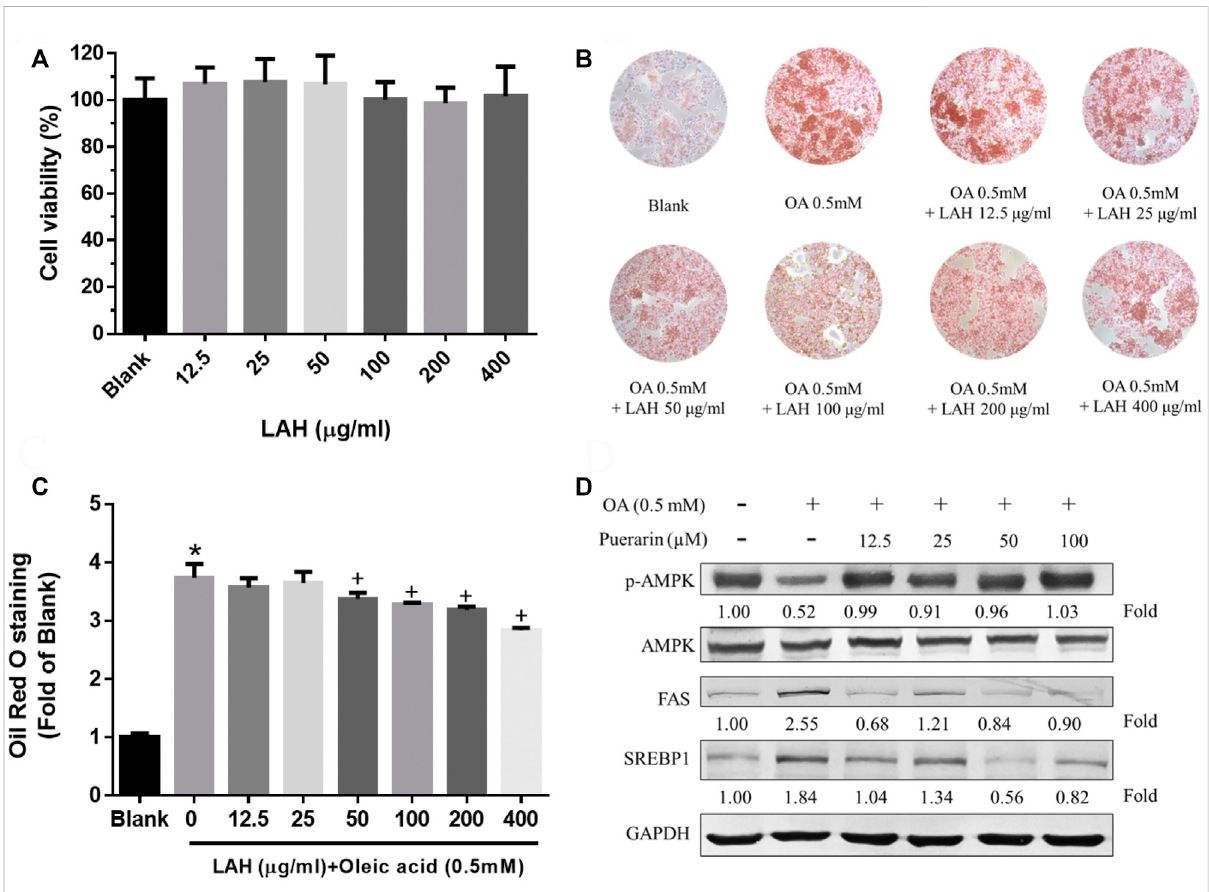
FIGURE 4 LAH and puerarin regulateOA-inducedlipogenesisin HepG2 cells. (A) Cell viability ofHepG2 cell treated with LAH, determined over 24 husing anMTTassay. (B) Cellswereplatedinto24wellplateandtreatedwithdifferentdosesofLAHinthepresenceofOA(0.5 mM)for24 h.OROstainingof HepG2cellsaftertreatmentwithOAandLAH. (C) QuantitativelipidaccumulationofOilRedOcontentsat520 nm. (D) PhosphorylatedAMPK,AMPK, FA,andSREBP1proteinlevelsbywesternblotanalysis.ProteinexpressionwasnormalizedtoGAPDH.Valuesareexpressedasmean±SD( n =3/ group). * p < 0.05 compared with Blank group. + p < 0.05 compared with OA